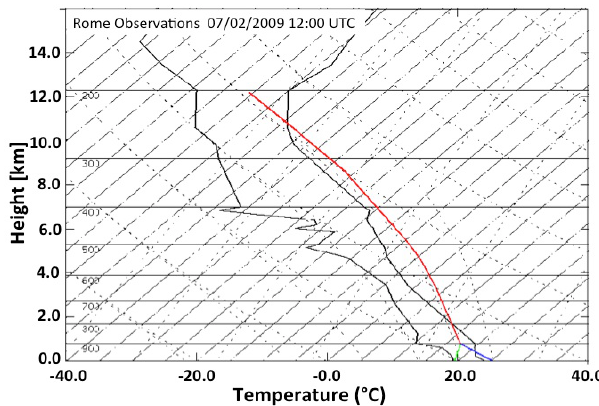
Fig. 9. Radio sounding in Rome on 2 July 2009, 12:00UTC (black curves), and initial perturbation setup for Case 2. The blue line is the dry adiabatic thermal perturbation, the green line represents the moisture of the thermal bubble, and the red curve is the moist adia- batic